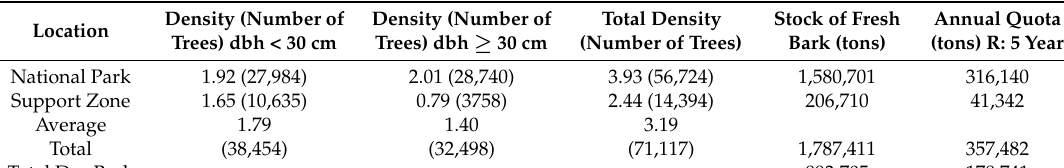
Table 1. Density and exploitable Prunus on Mount Cameroon [17].